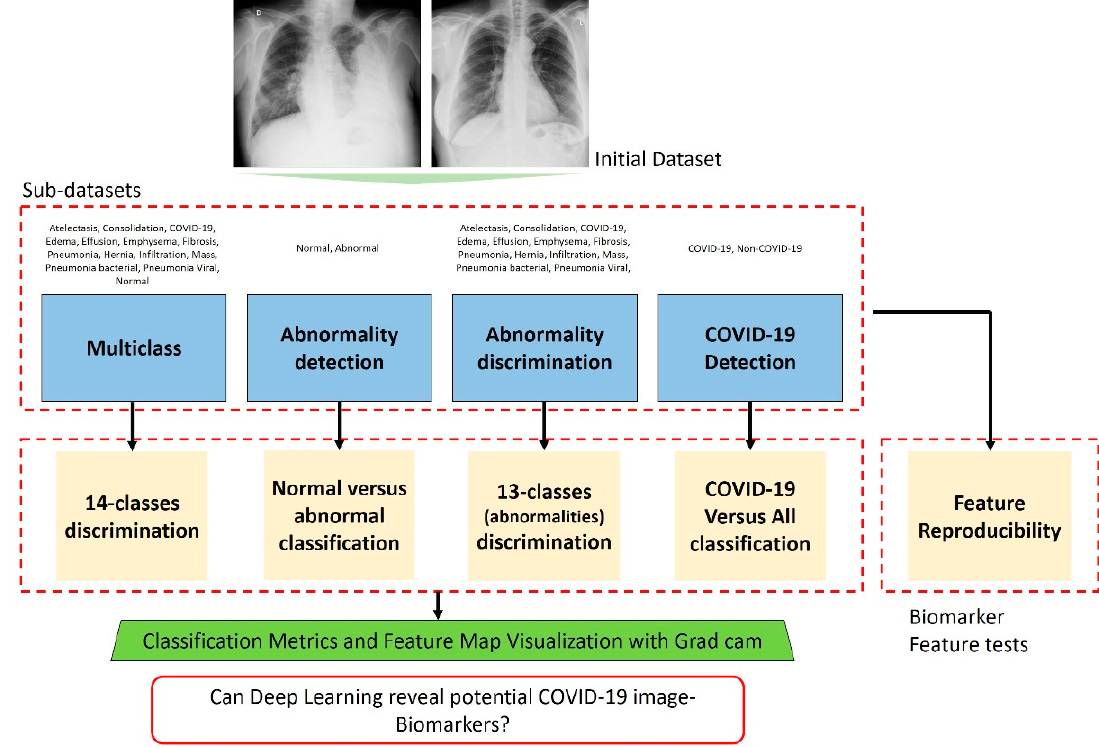
Figure 2. Overview of the experiments of this study.